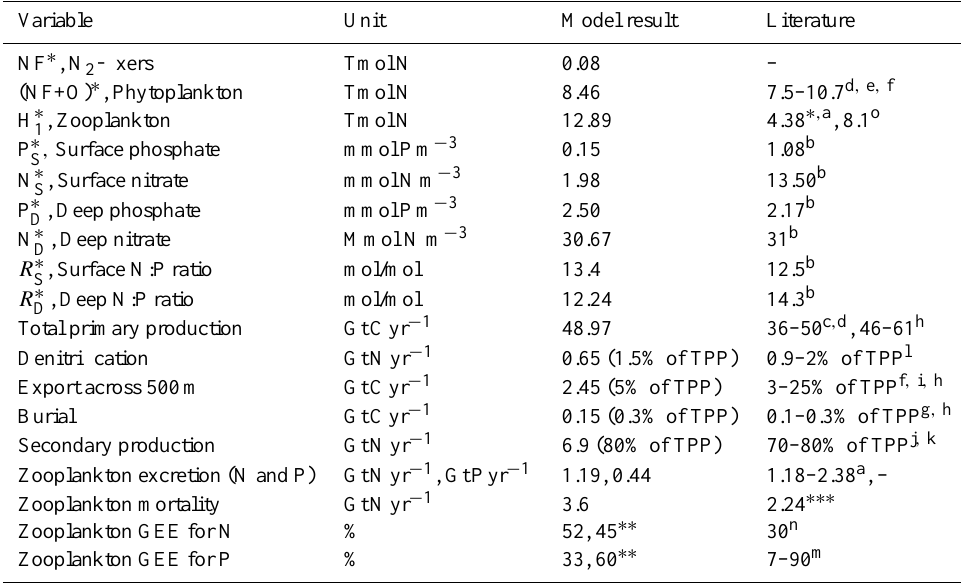
Table 2. Comparison of model solutions at steady-state with values from the literature. Variable Model